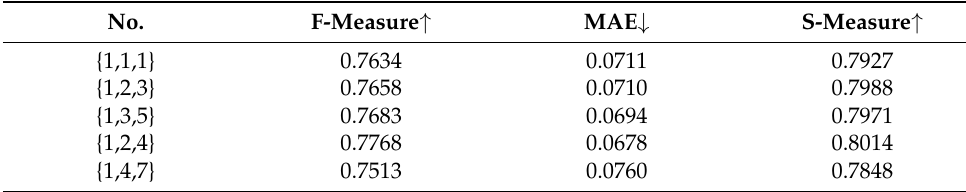
k F-Measure ↑ MAE ↓ S-Measure ↑ 1 0.7534 0.0742 0.7860 2 0.7517 0.0756 0.7859 3 0.7634 0.0711 0.7927 4 0.7578 0.0741 0.7899 5 0.7588 0.0715 0.7881